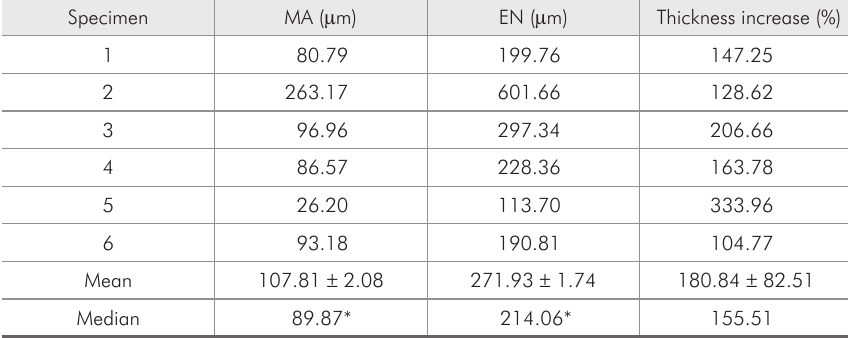
Table 2 - Epithelial lining thickness of KOTs in the specimens obtained from marsupialization (MA) and enucleation (EN; n =